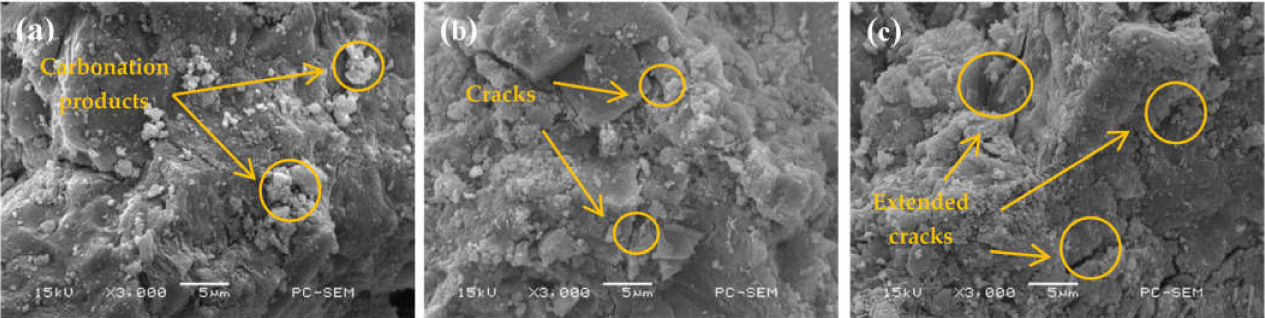
Figure 9. SEM images of RAC-1 with different replacement rates carbonated for 28 d after 600 times of freeze–thaw cycles: ( a ) 25%; ( b ) 75%; ( c )